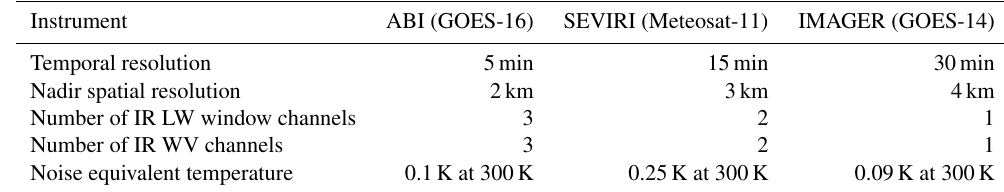
Table 1. Comparison of data from ABI to those from older geostationary instruments. Instrument ABI